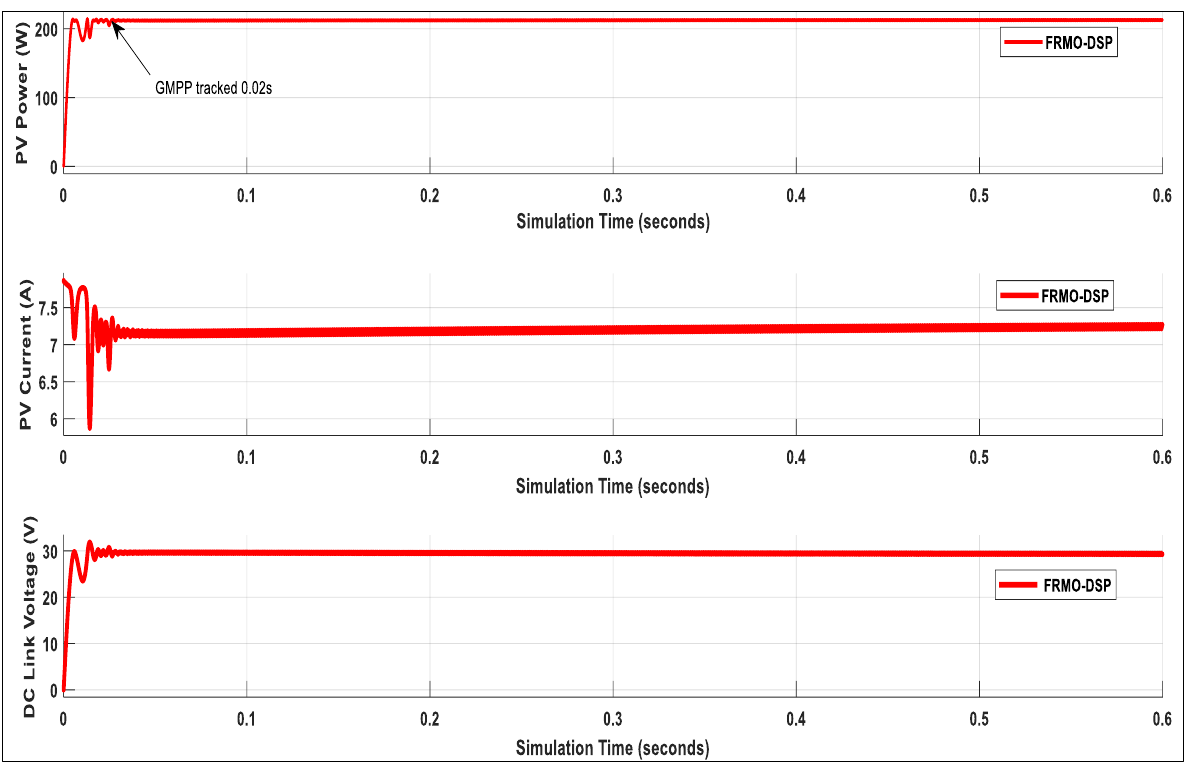
Figure 8. PSC pattern 1 FRMO-DSP MPPT results (case study 1).